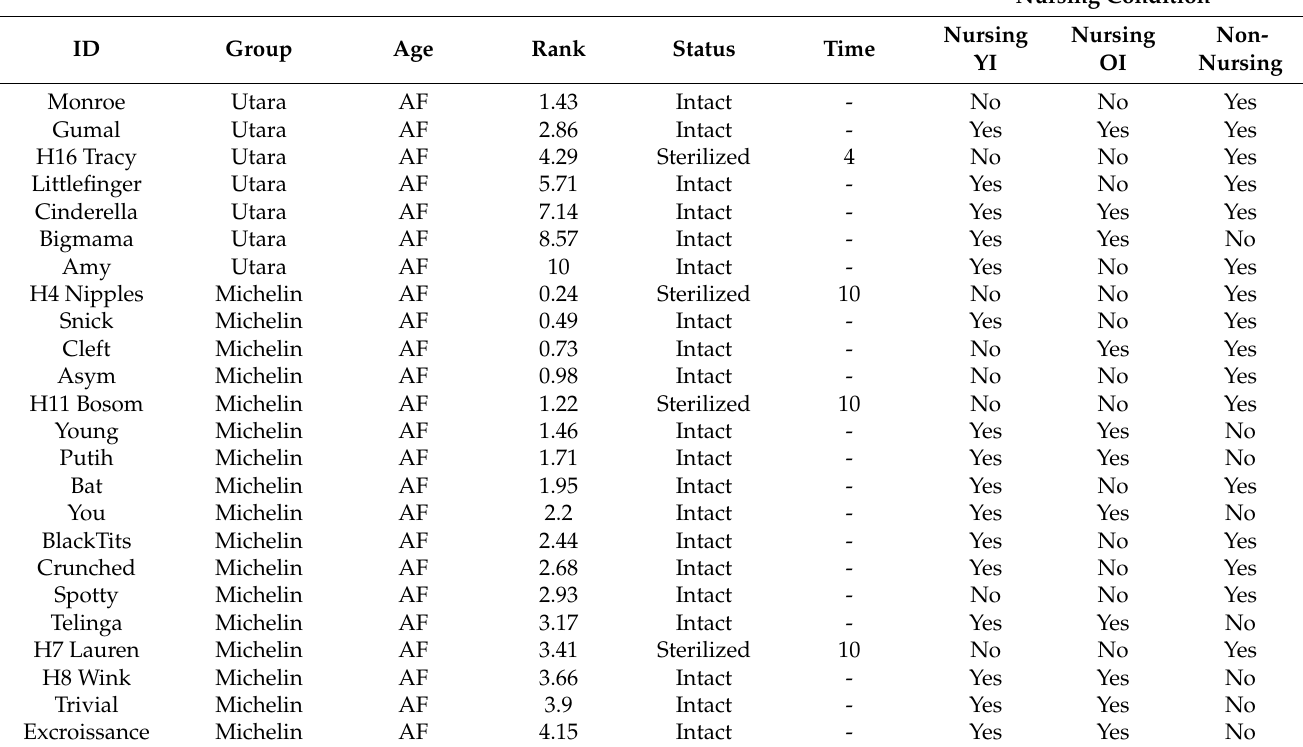
Table A2. Summary of the focal subjects, with for each of them: group, age class (adult female vs. subadult female), standardized hierarchical rank, fertility status (intact vs. sterilized), time (in months) elapsed (by the middle of the study) since sterilization surgery, and the nursing conditions (nursing a young infant (YI), nursing an old infant (OI), non-nursing females) experienced during the study